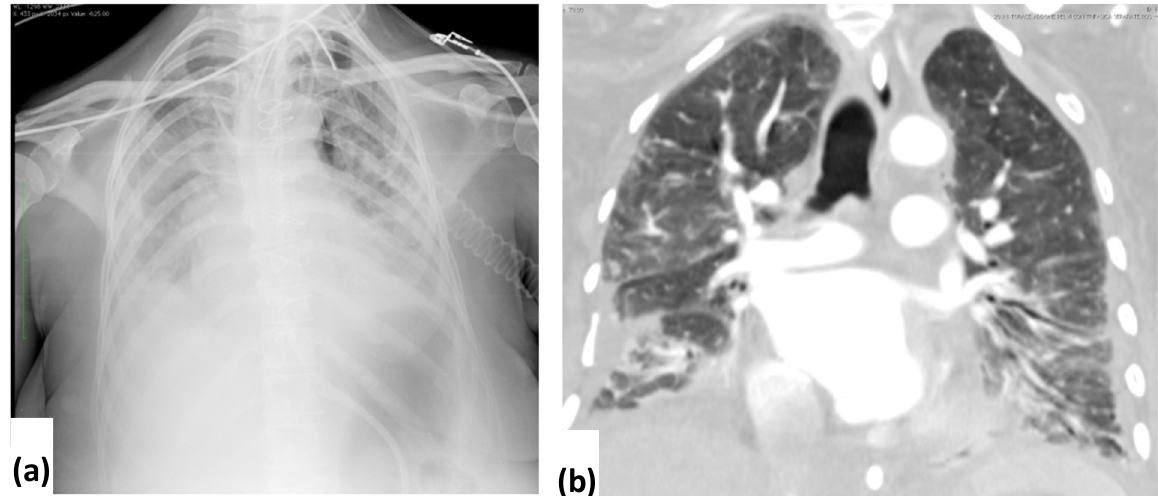
Figure 3. Portable CXR ( a ) and CT images ( b , coronal) of a 55-year-old male patient: note the predominant involvement of the middle and lower lung zones with bilateral distribution.